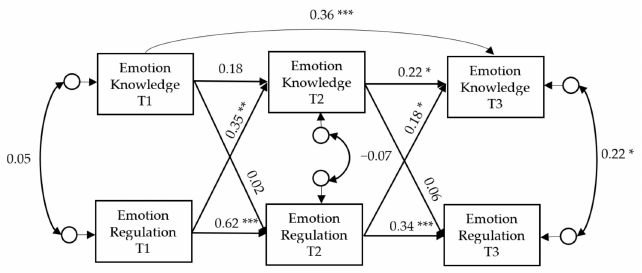
Figure 1. Cross-lagged model for testing the longitudinal association between emotion knowledge and emotion regulation across the three measurement times. Values are standardized coe ffi cients. * p < 0.05; ** p < 0.01; *** p <